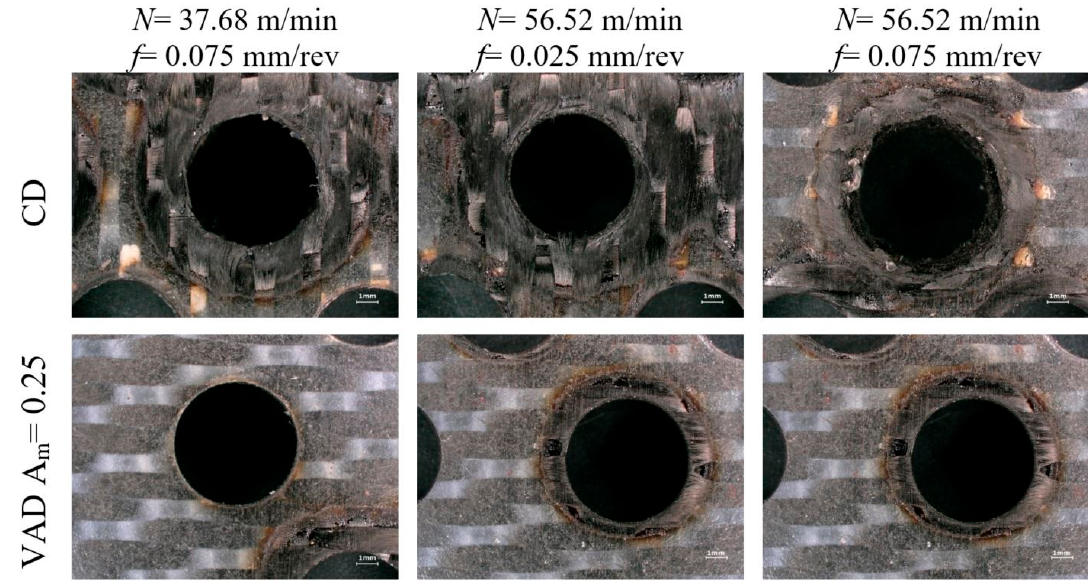
Figure 20. The effect of machining technique on the exit delamination the end of each machining parameters.